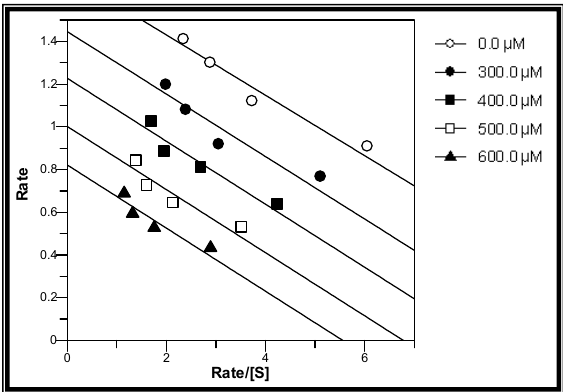
Figure 2. Lineweaver–Burk plot of reciprocal of rate vs reciprocal of fixed substrate concentration in absence and presence of different concentration of 1.